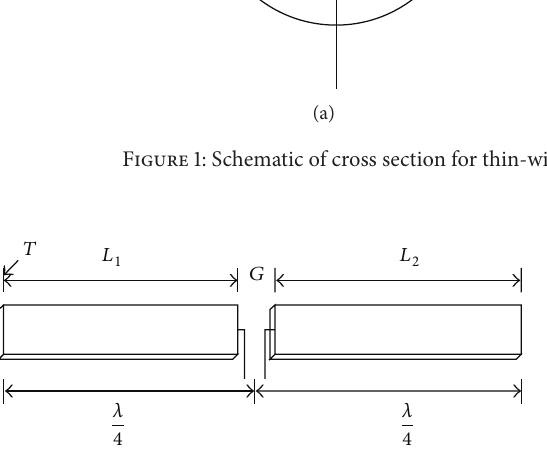
Figure 2: Schematic of strip dipole